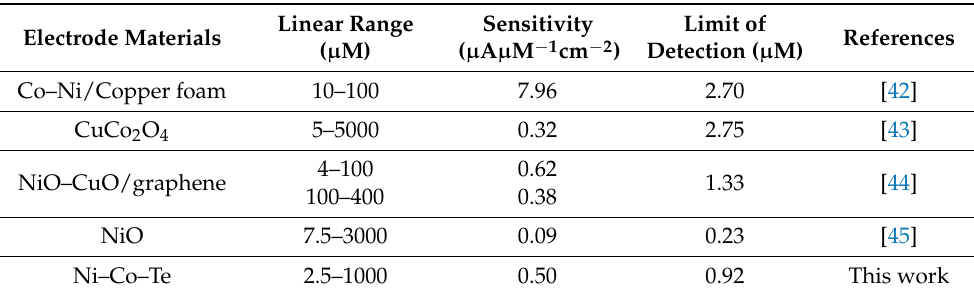
Table 2. Comparison of the performance of electrochemical acetaminophen sensing using transition metal compounds based materials.